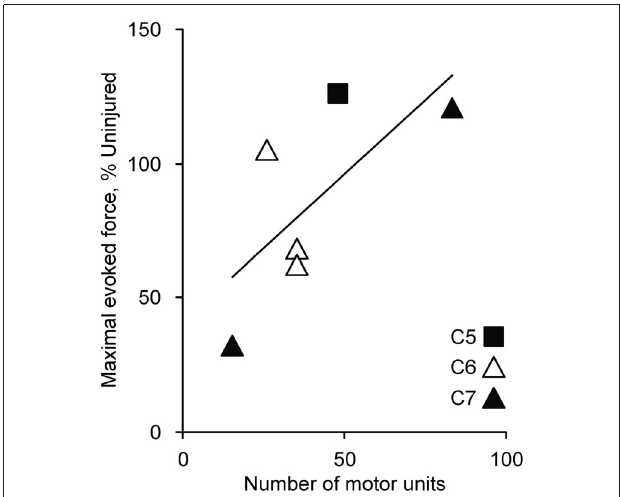
FIGURE 2 | Number of motor units in relation to maximal thenar muscle force evoked by supramaximal median nerve stimulation and expressed relative to uninjured means ( n = 6 subjects)